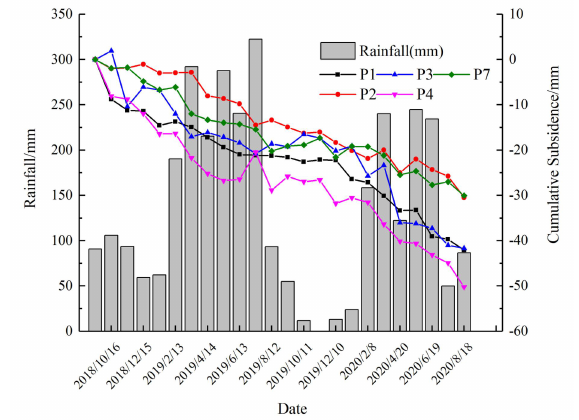
Figure 8. Comparison of rainfall and surface subsidence rate